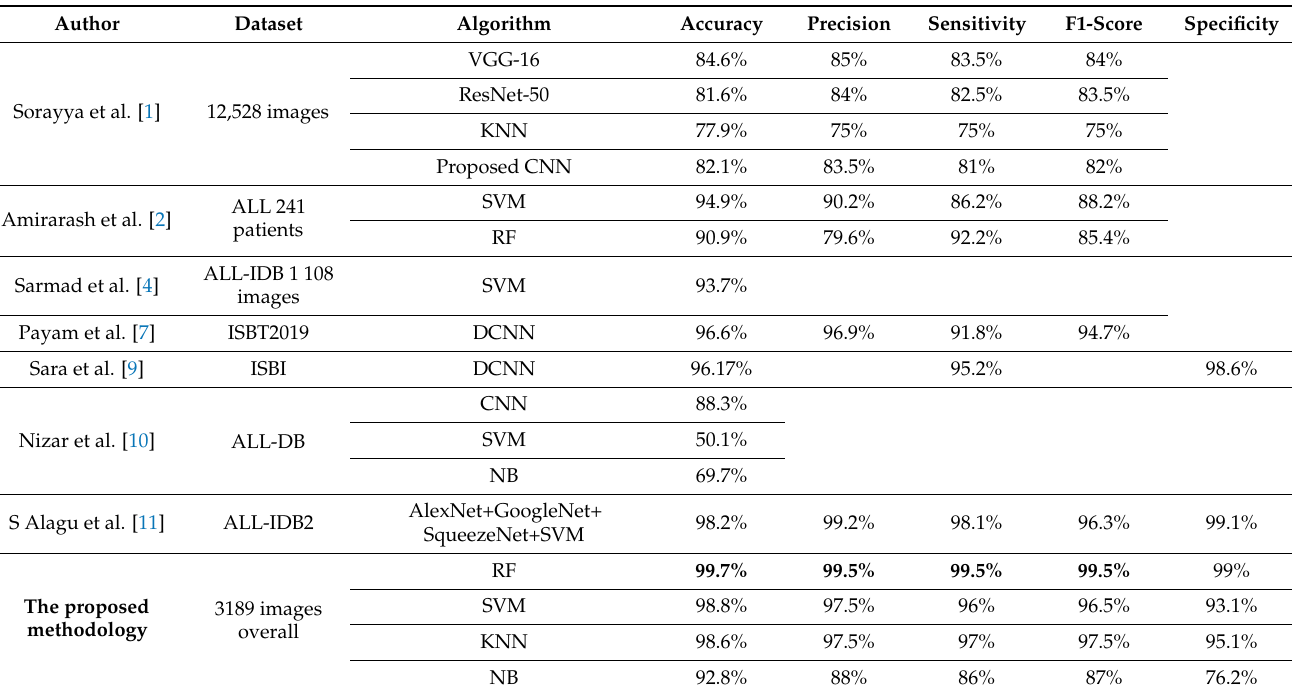
Table 6. Performance comparison of the proposed method and other machine learning